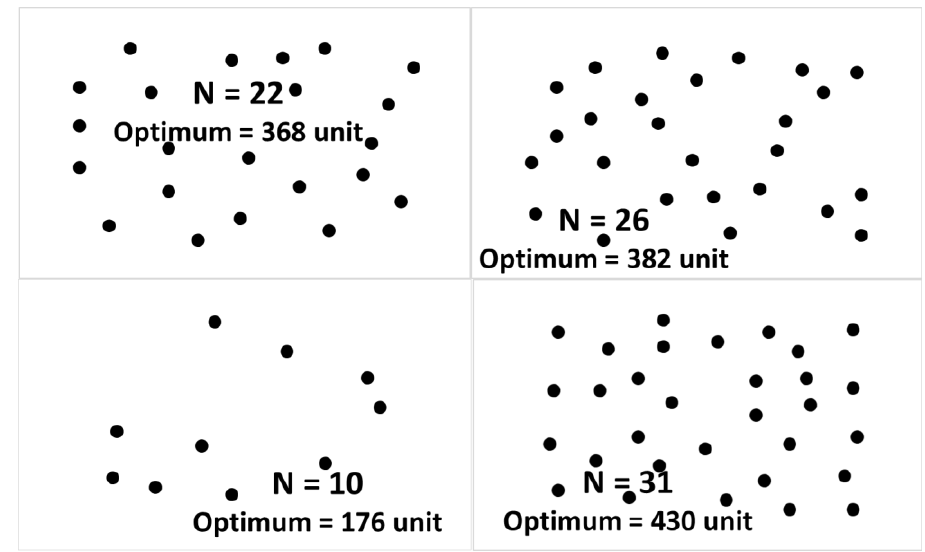
Figure 25. Screenshots of 4 different dots instances (in the same order).